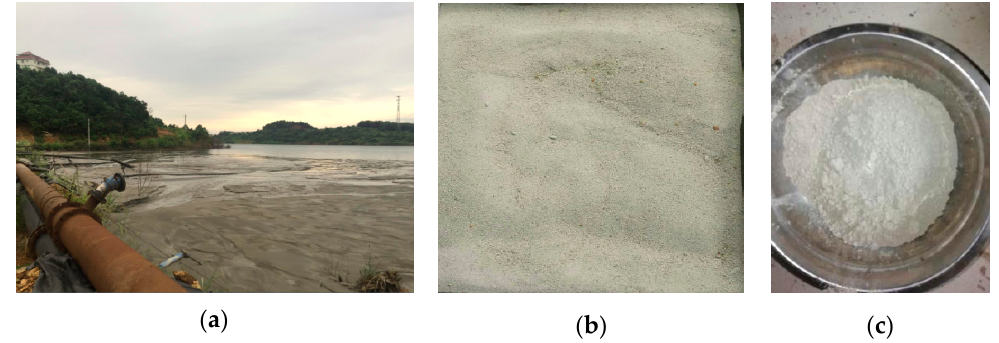
Figure 1. Copper tailing powder in copper tailing reservoir. ( a ) Reservoir of copper tailing; ( b ) copper tailing; ( c ) copper tailing power.